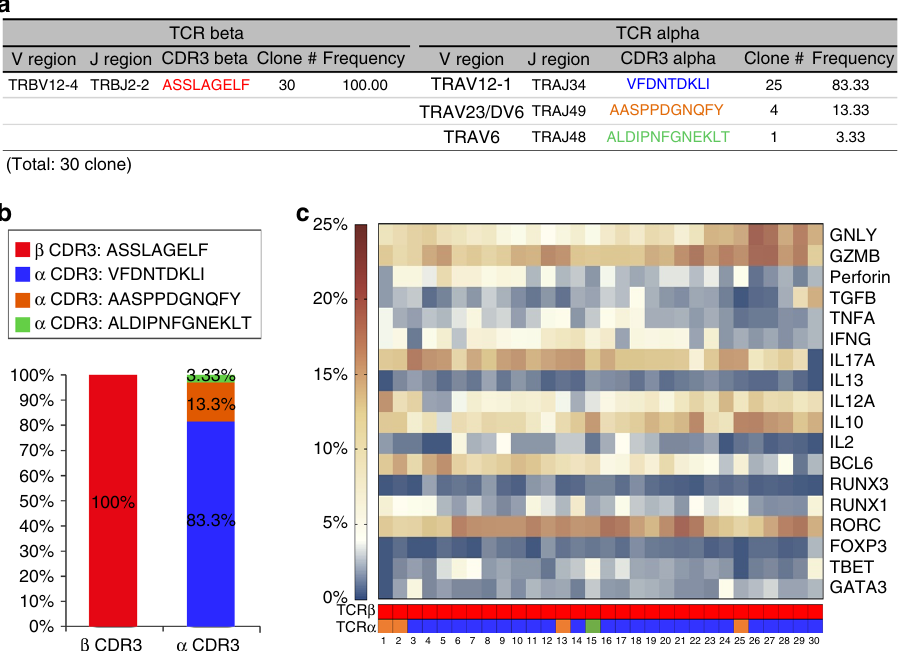
Fig. 4 Single-cell sequencing on the TCR α /TCR β gene pairing and gene pro fi le. The blister cells of a patient with CBZ-SJS/TEN (case 4) were sorted by fl ow cytometry using mAb recognizing human TCR TRBV12-3/TRBV12-4 (Beckman Coulter). A total of 30 lymphocytes were analyzed by single-cell sequencing to determine the V/J usage, CDR3 TCR α /TCR β clonotypes, and the transcripts of 18 genes. a , b The speci fi c TCR β CDR3 clonotype “ ASSLAGELF ” was detected in all (100%, 30/30) single-cell clones. Twenty- fi ve (83.33%) clones expressed the TCR α CDR3 clonotype “ VFDNTDKLI ” , four